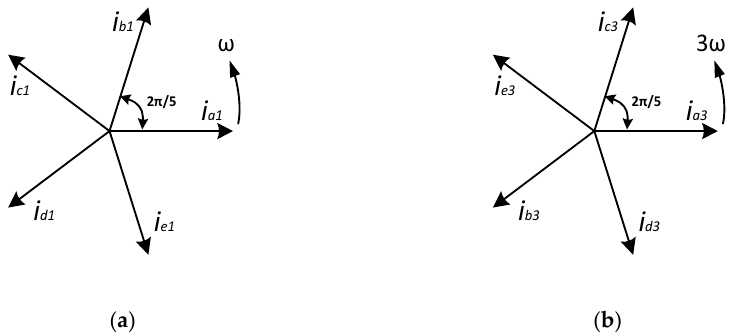
Figure 1. Phasor diagram of the phase current components: ( a ) Fundamental; ( b ) third harmonic.